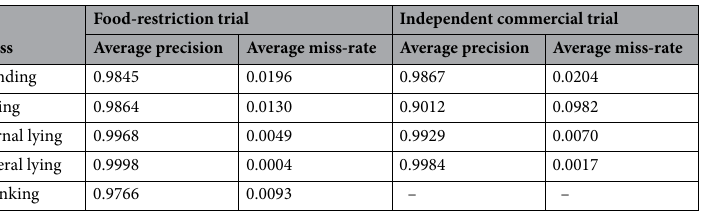
Table 2. The average class precision and average class miss-rate for our primary model, YOLO detector with 3 anchor boxes. This model achieves high precision and low miss-rate across classes of both: the food-restriction trial and an independent commercial pig trial. The drinking sources were outside the camera field-of-view in the latter trial.